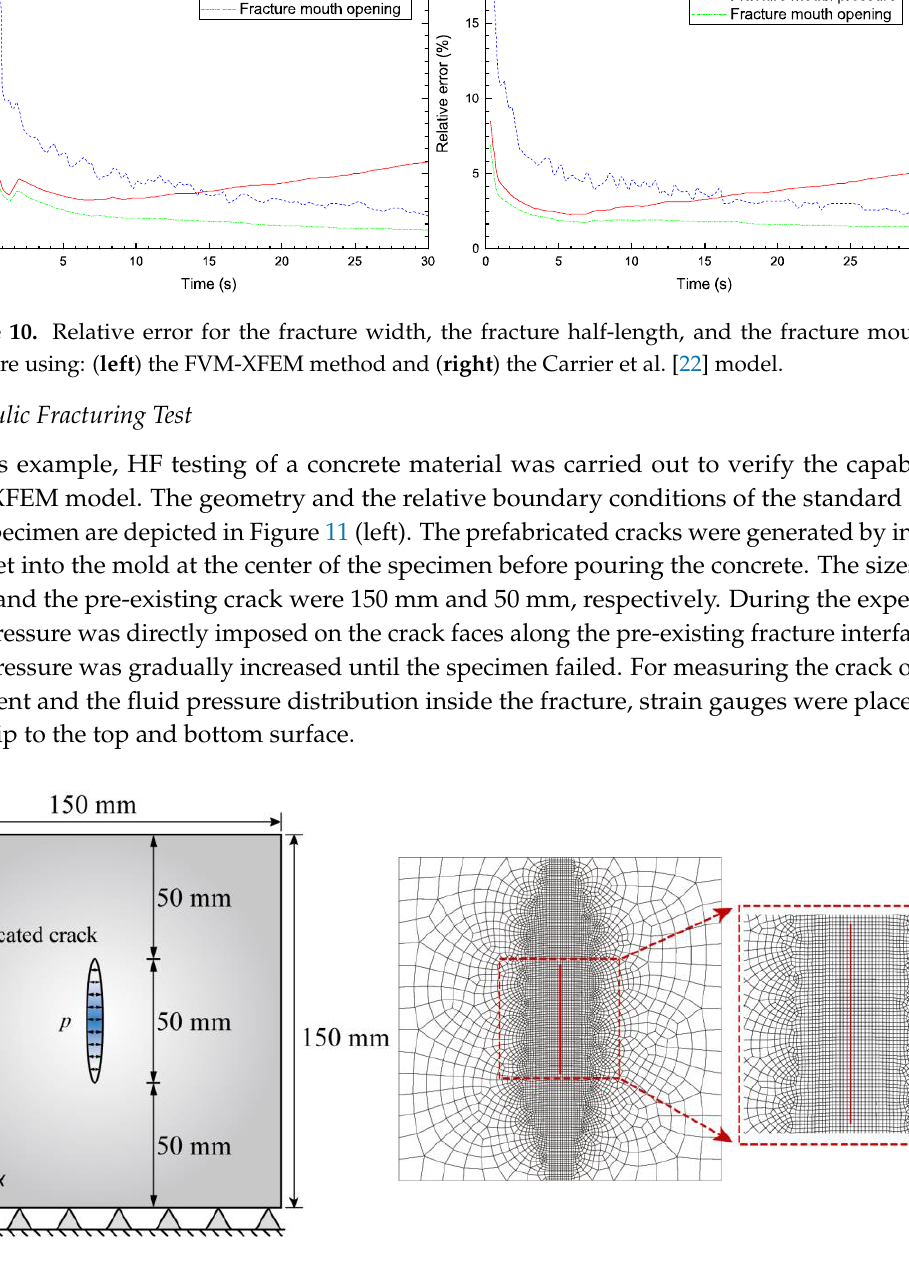
Figure 11. A schematic illustration of the hydraulic fracturing (HF) test: ( left ) Problem definition and ( right ) the XFEM meshes.